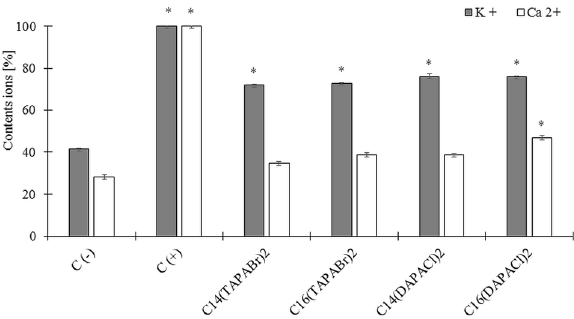
Figure 4. Potassium ion (K + ) and calcium ion (Ca 2+ ) leakage from C. albicans cells after exposure to dicephalic